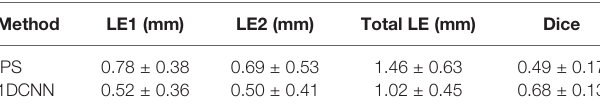
TABLE 3 | The average and standard deviation of the LE and Dice for the dual- source reconstruction in test set. Method